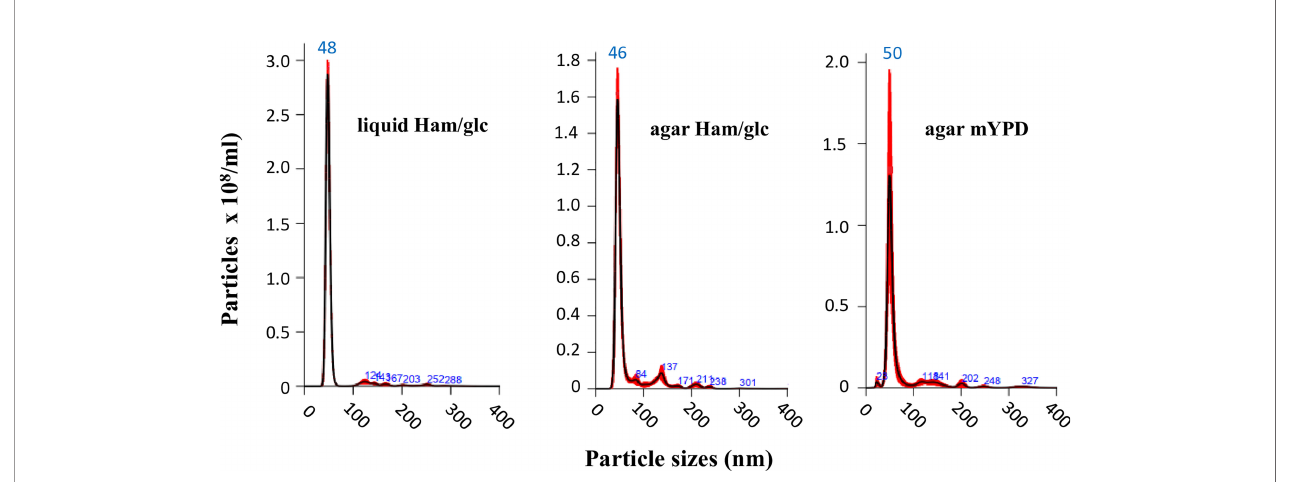
FIGURE 1 | Comparative NTA analysis of extracellular vesicles (EVs) isolated from the yeast form of Paracoccidioides brasiliensis vPb18 cultivated in either liquid Ham/glc medium or Ham/glc and mYPD agar plates, as indicated. The graphics show the EV particle concentration (particles/ml) relative to the particle diameter